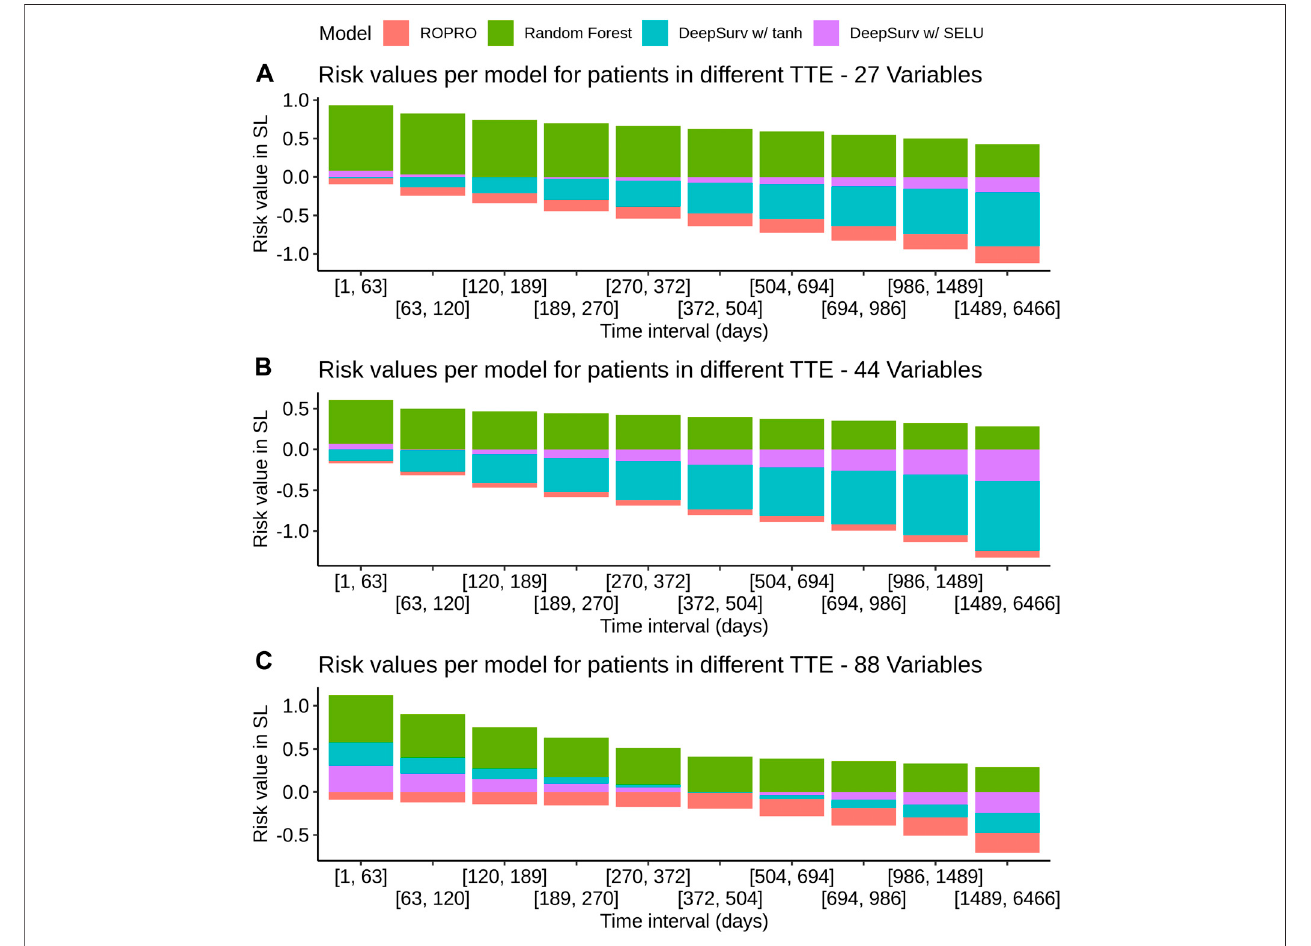
FIGURE5| Individualmodel contributiontotheSLriskbytime-to-eventin theFHtraining set.Tocreate thisvisualization,the patients weresplitinto groupsbased on their time to event (TTE). Each of these groups is represented in the x -axis. Then, for each group the median risk value per model was calculated and is displayed on the y -axis. The contribution changes over time because the models correctly assign higher risk for lower times-to-event and lower risk for later times-to-event.